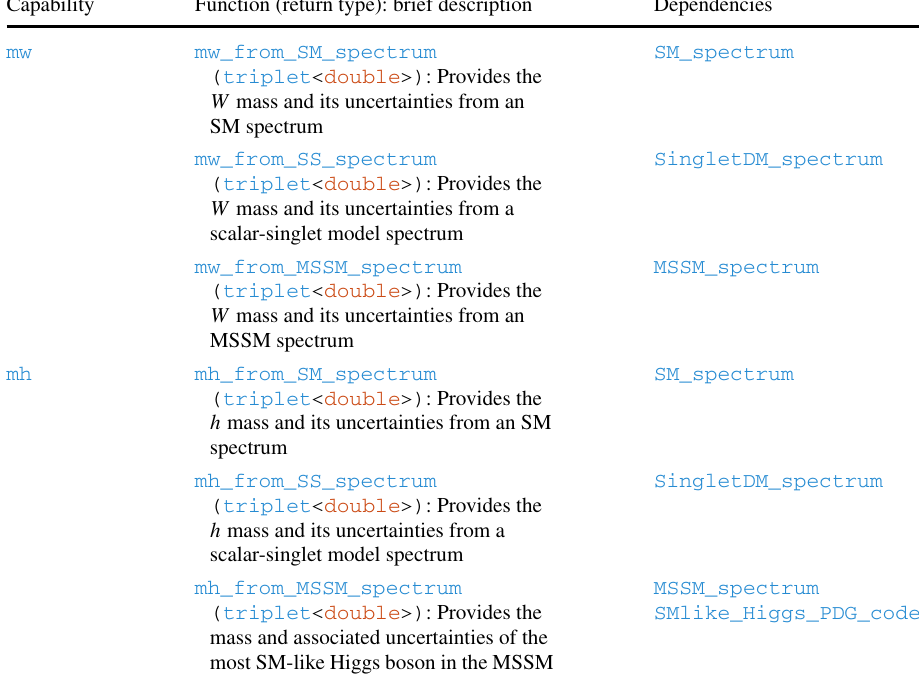
Table 9 Summary of PrecisionBit module functions providing the W and h masses from different GAMBIT Spectrum inputs.